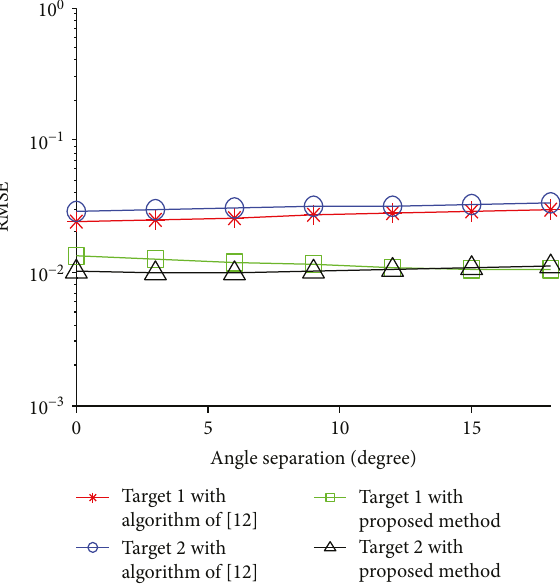
Figure 7: RMSE of elevation estimation versus angular